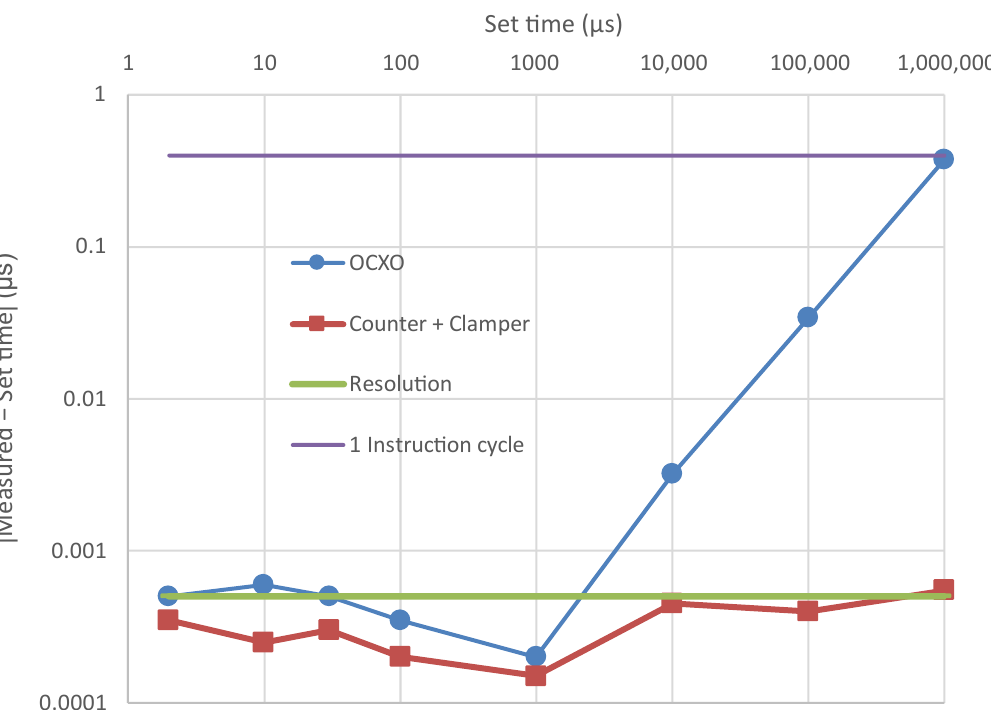
Figure 10. Repeated time delay measurement results.